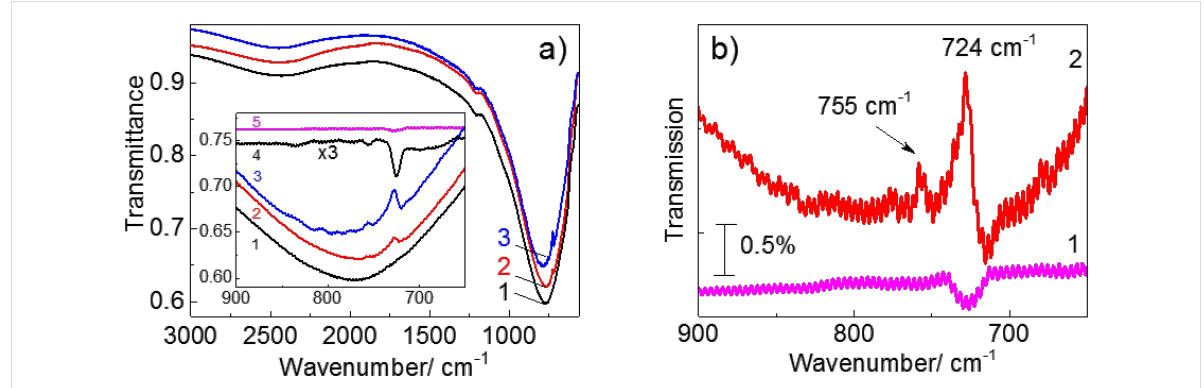
Figure 4: (a) IR spectrum of bare nanoantennas (curve 1) and IR spectra of nanoantennas with deposited 3 nm and 10 nm thick CoPc films (curves 2 and 3, respectively). The inset shows a comparison of the same spectra with the IR spectra of 3 nm and 10 nm thick CoPc films on a Si substrate without nanoantennas (curves 4 and 5, respectively). (b) Comparison of IR spectrum of bare nanoantennas (curve 1) and with the spectrum of the structure with the 3 nm thick CoPc film (curve 2) after background subtraction.